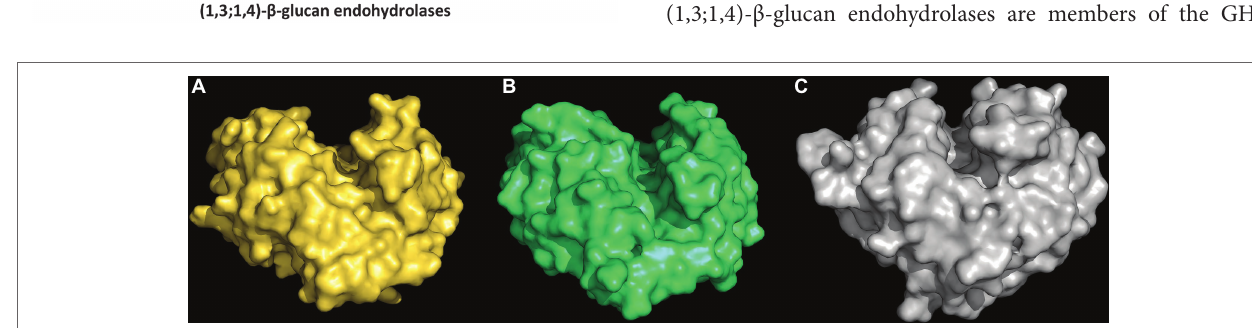
FIGURE 7 | 3D structures of a (1,3;1,4)- β -glucan endohydrolase (A) , a (1,3)- β -glucan endohydrolase (B) from barley, and a (1,3)- β -glucan endohydrolase (C) from Bacillus subtilis . The (1,3;1,4)- β -glucan substrate-binding clefts extend across the surface of the enzymes in each case and the catalytic acid and base residues